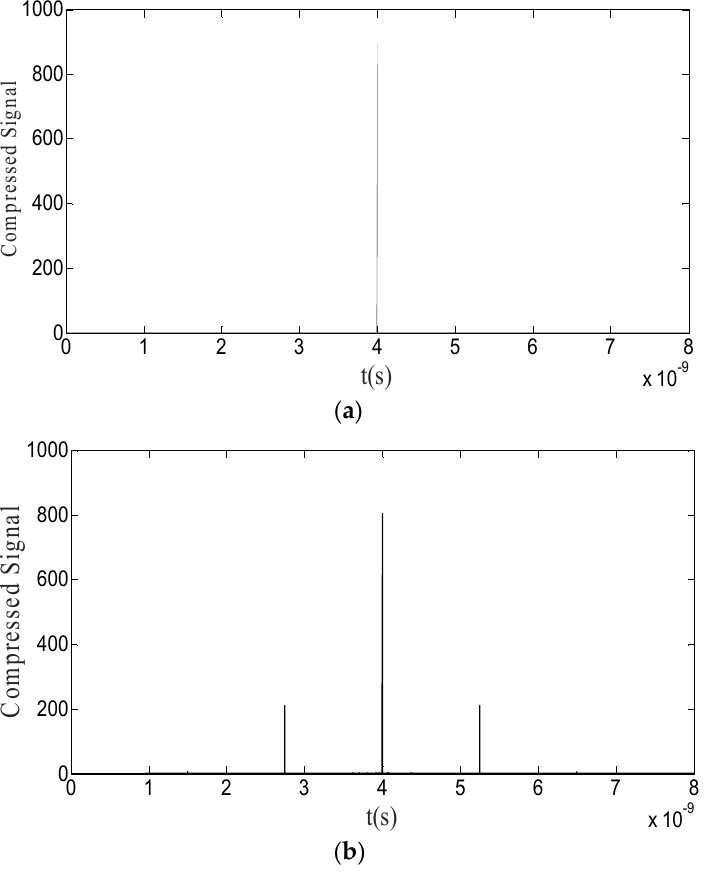
Figure 6. The compressed laser pulses for modulating frequencies ( a ) 100 MHz and ( b ) 1.2 GHz.